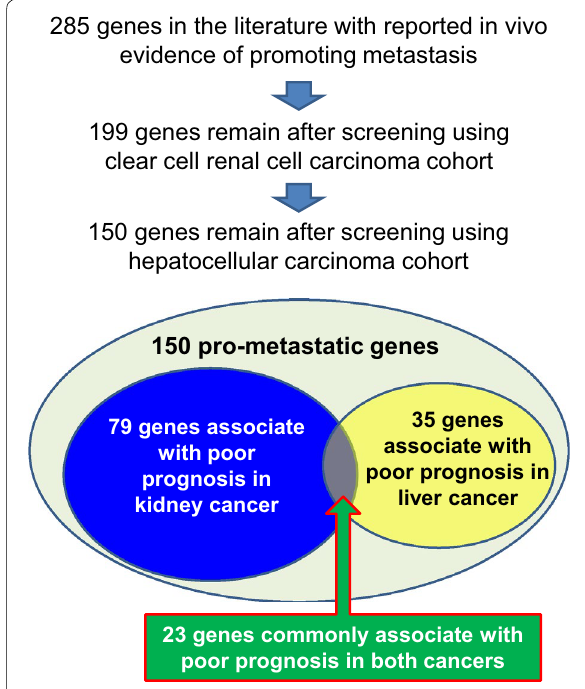
Fig. 1 A schematic illustration of the study design and findings